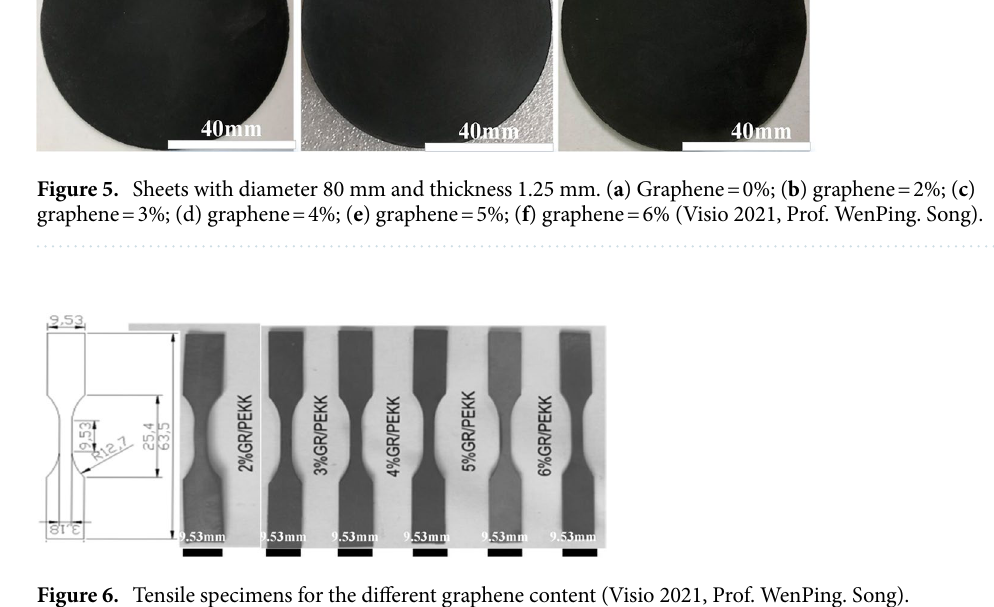
Figure 6. Tensile specimens for the different graphene content (Visio 2021, Prof. WenPing.